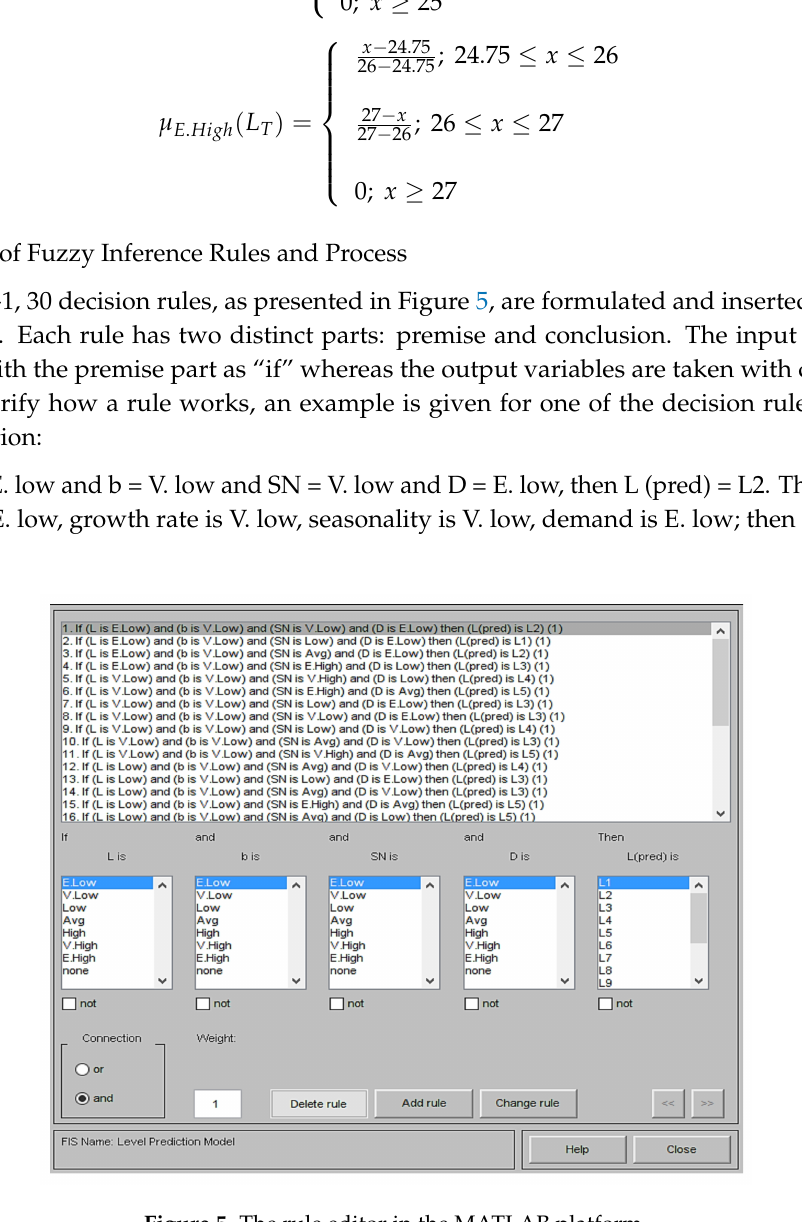
Figure 5. The rule editor in the MATLAB